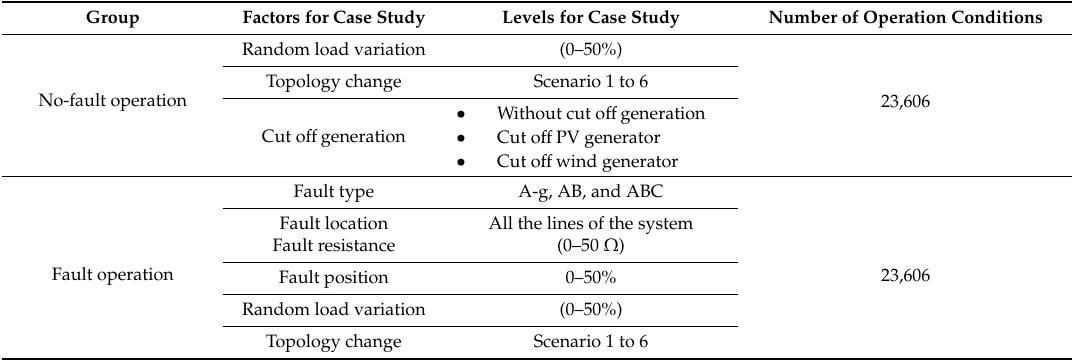
Table 6. Factors and level for case